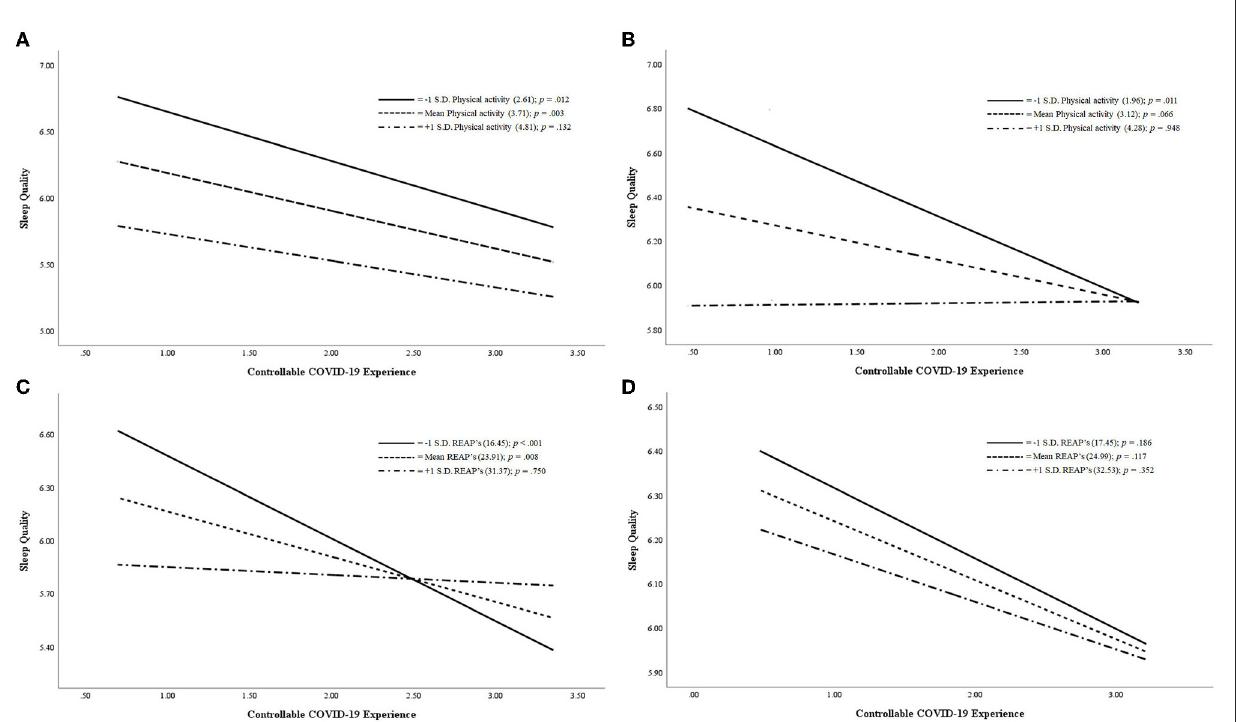
FIGURE4 The moderating effect of physical activity level (A, B) and dietary habits (C, D) on sleep quality by controllable COVID-19 experience in elite and amateur